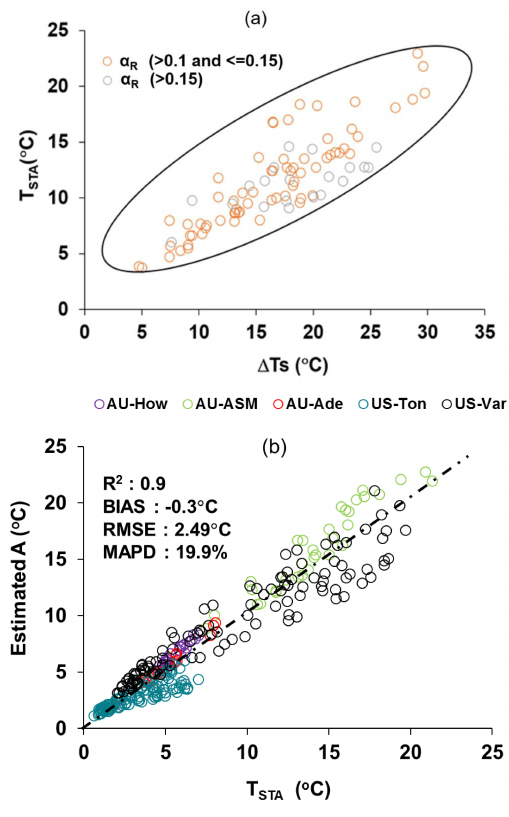
Figure 5. (a) Two-dimensional scatterplots between ( (cid:49) Ts) versus T STA at different α R levels over different ecosystems. Here T STA on the y axis is the observed soil temperature amplitude that is used to develop the scaling function, and (cid:49) Ts is the noon–night LST difference of MODIS AQUA. (b) Validation of ecosystem-scale es- timates of A from the above functions over different sites.